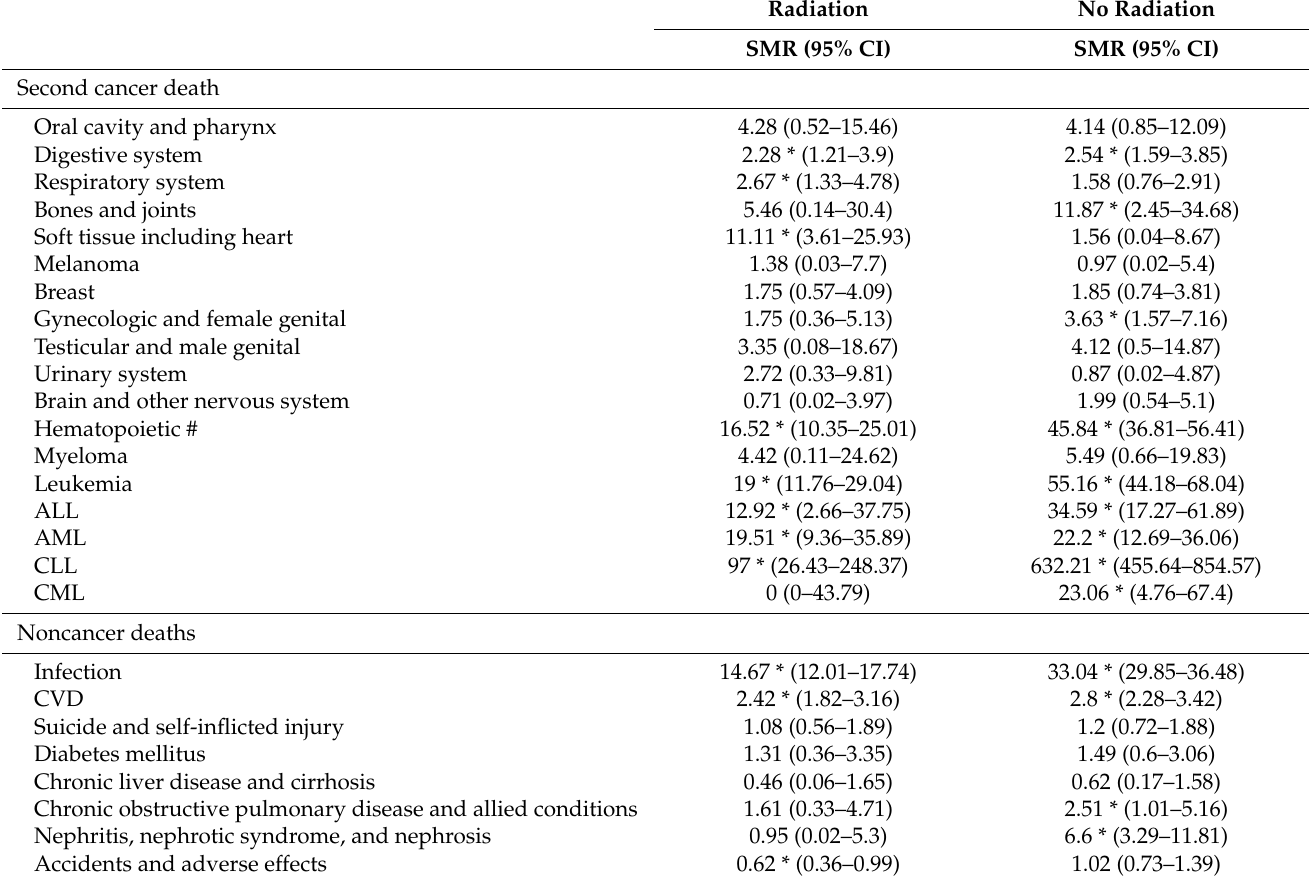
Table 4. Standardized mortality ratios for nonrecurrence death after a lymphoma diagnosis among AYA patients according to cause of